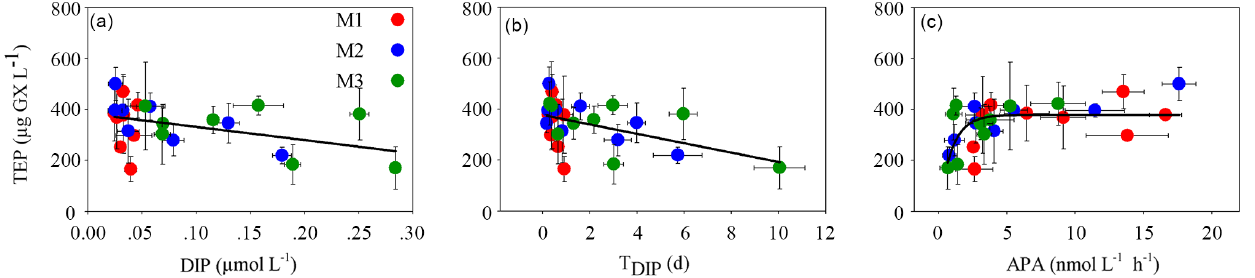
Figure 3. Relationships between the concentration of transparent exopolymeric particles (TEP), (µgGXL − 1 ) and (a) dissolved inorganic phosphorus DIP (µmolL − 1 ), (b) turnover time of DIP – T DIP (days), and (c) alkaline phosphatase activity (APA) (nmolL − 1 h − 1 ) in the three mesocosms (M1– red; M2– blue; M3– green) during phase 2 (days 15–23). For (a) and (b) Pearson linear regressions yielded an R 2 of 0.54, n = 23 (TEP / DIP), and an R 2 of 0.52, n = 26 (TEP /T DIP ), and for (c) log-transformed (log(TEP) / log(APA)) with an R 2 of 0.68, n = 25. All correlations were significant ( p < 0.05). Error bars represent ± 1 standard